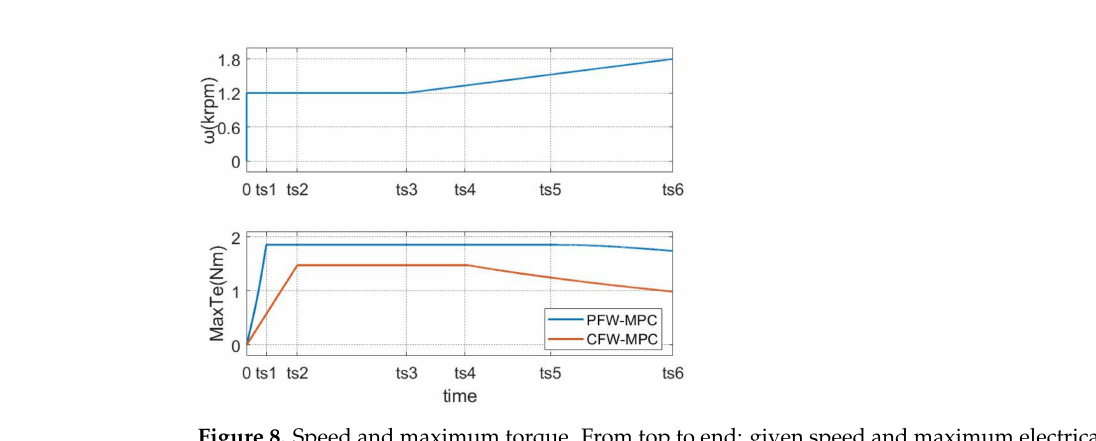
Figure 8. Speed and maximum torque. From top to end: given speed and maximum electrical torque.